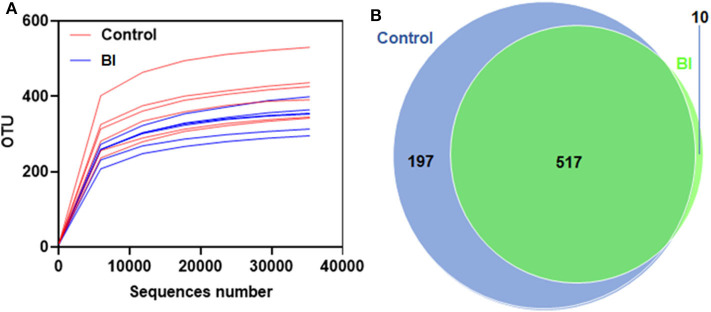
Rarefaction curves for the control group and 2% BI administration group. On day 28, the feces were collected to evaluate the gut microbiota using unique OTUs. (A) Rarefaction curves showing unique OTUs at the 97% threshold. (B) Venn Graph showing common and unique OTUs in the control group and 2% BI administration group. Control, control diet; BI, B. inquinans.